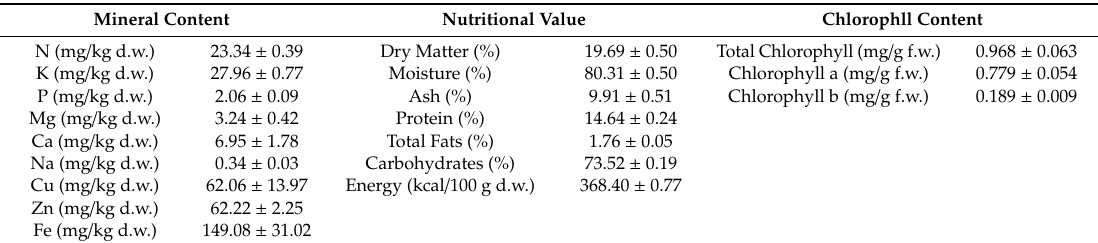
Table 1. Mineral analysis, nutritional value and chlorophyll content of aerial plant tissue. Data are presented as the mean of six replicates ± SD. Mineral Content Nutritional Value Chlorophll Content N (mg / kg